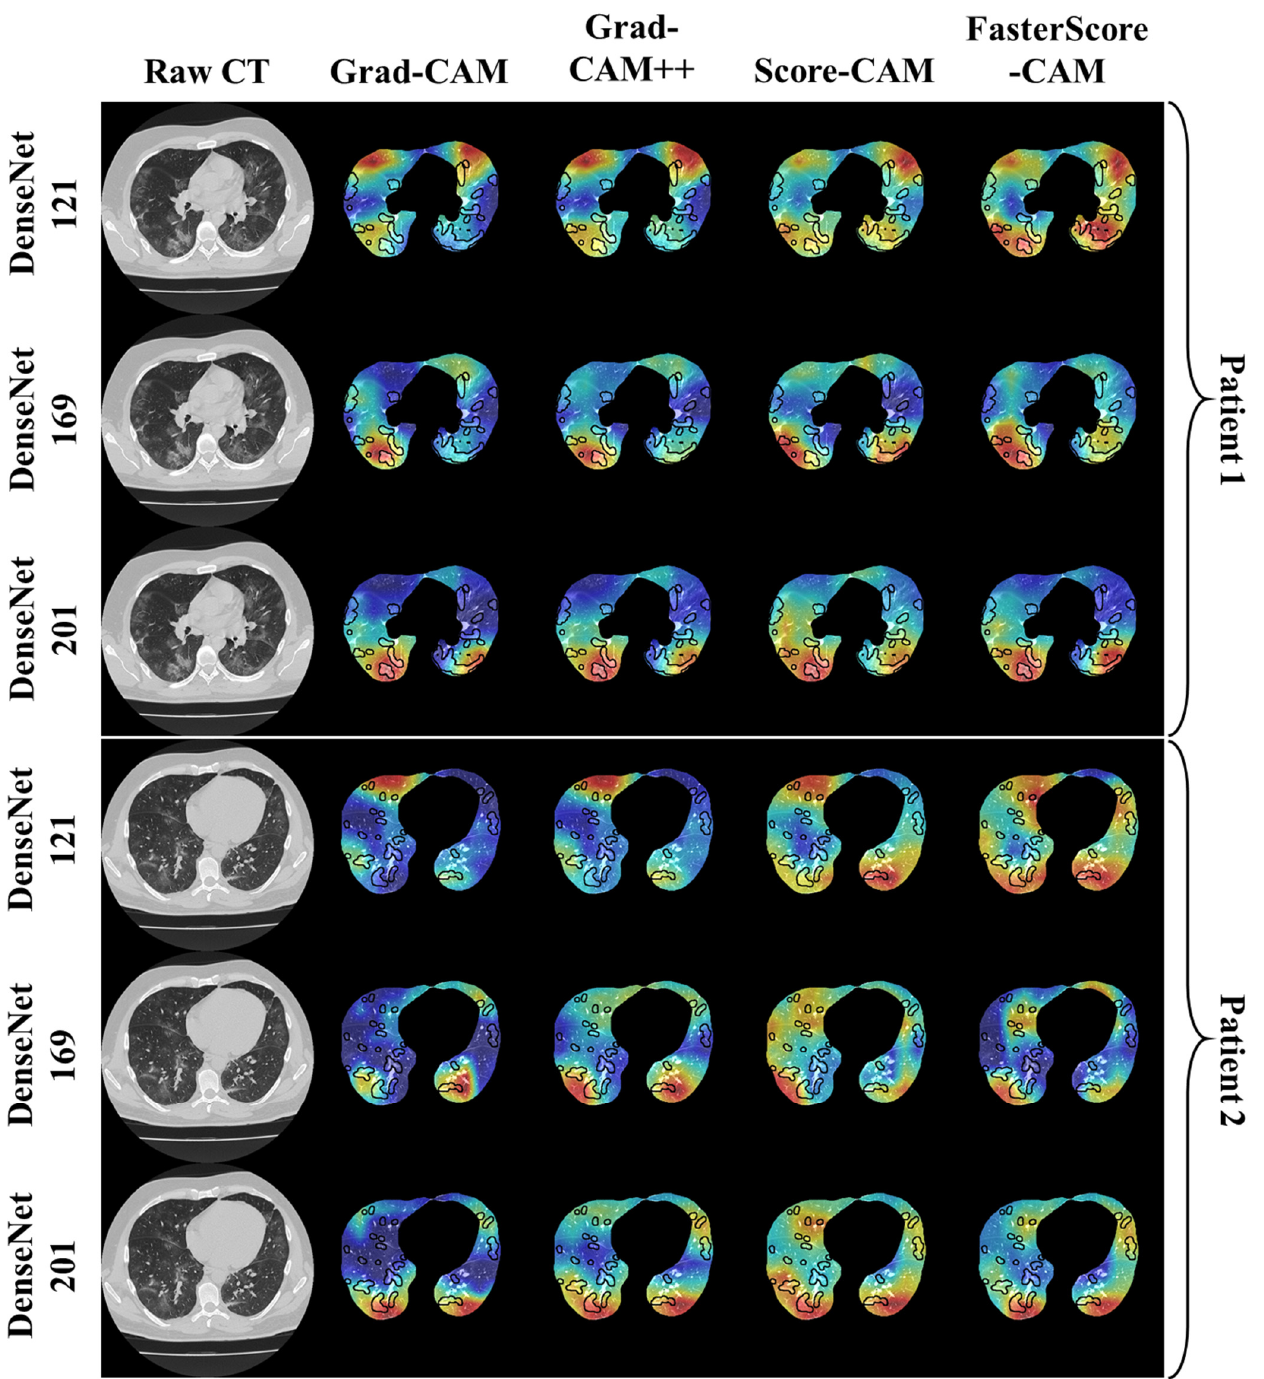
Figure 16. Overlay of ground truth annotation on heatmap using four CAM techniques on three kinds of DenseNet classifiers for COVID-19 lesion images as part of the performance evaluation.